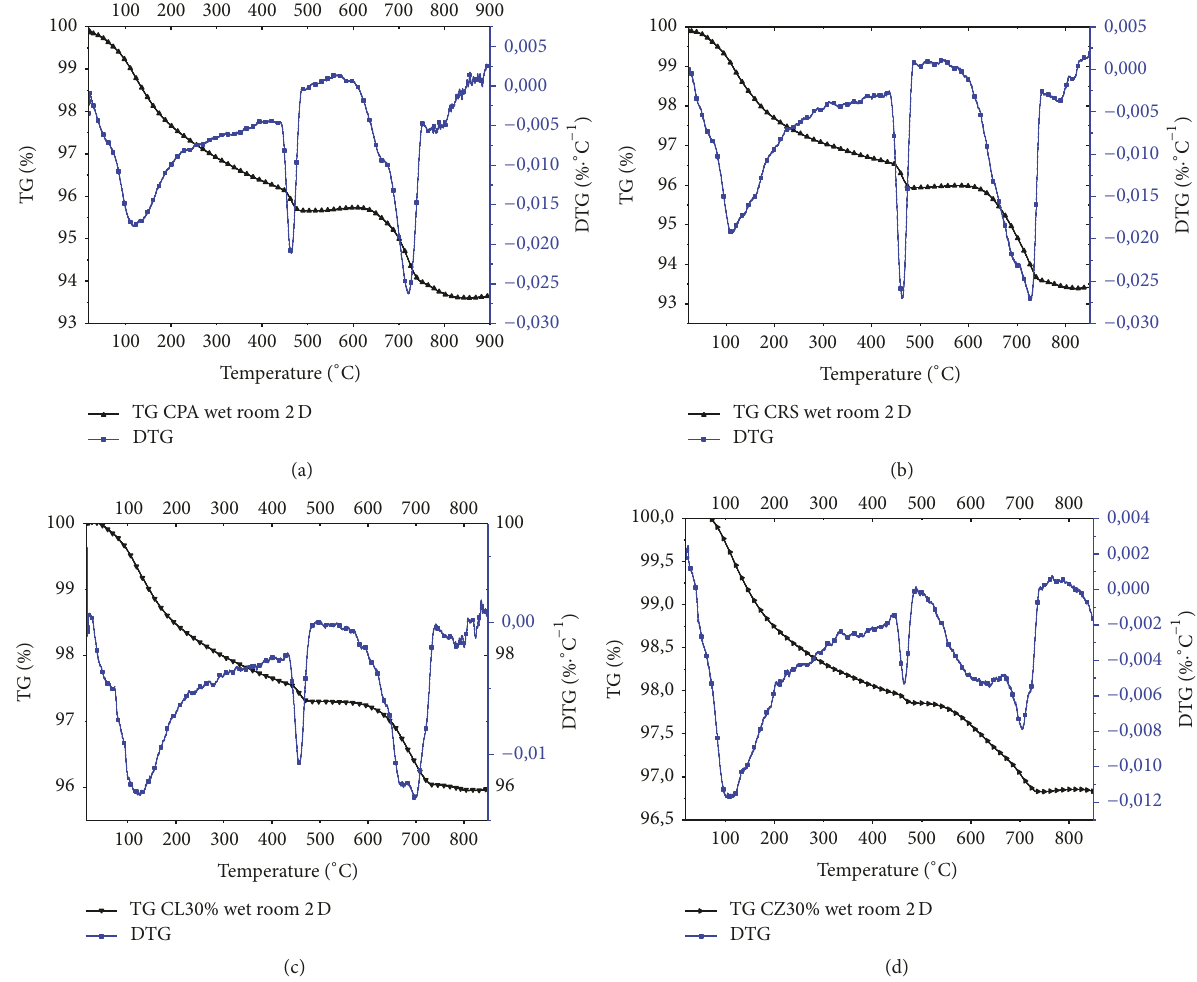
Figure 5: DTG/TG cement paste preserved in wet cure (RH = 95%, 𝑇 =20 ∘ C) for 2 days; (a) CPA/(b) CRS/(c) CL30% (30% slag)/(d) CZ3% (30%